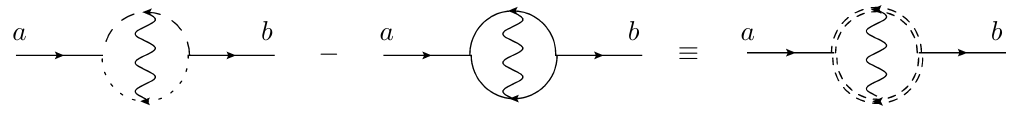
Figure 7 . A class of diagrams that correct the scalar propagator at two loops. The dashed double-line notation in the right-hand side is a convenient way to represent this contribution in the di(cid:11)erence